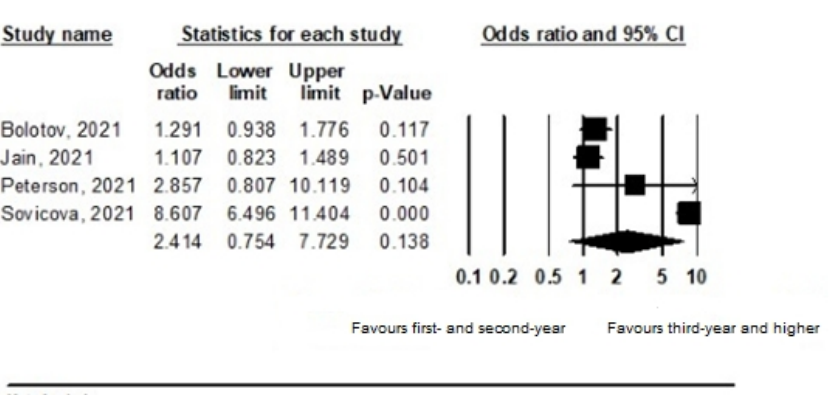
Figure 4. Forest plot representing the relationship between vaccination acceptance and year of study .